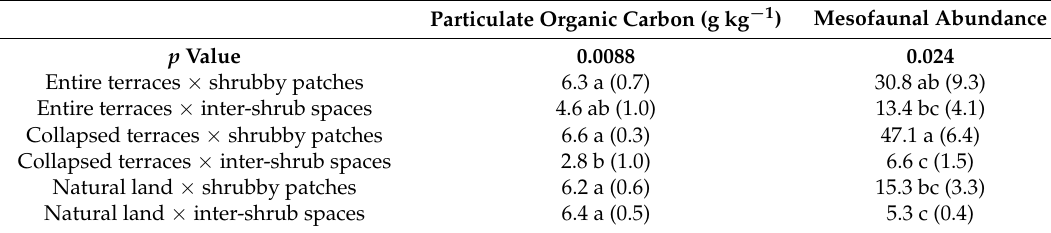
Table 4. Effect of the interaction land-use × micro-habitat on soil